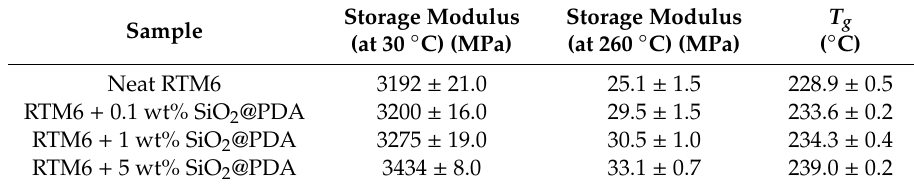
Figure 9. (a) Dynamic mechanical analysis (DMA) curves of neat epoxy and SiO 2 @PDA / RTM6 systems and ( b ) scheme of physical crosslinking of SiO 2 @PDA with epoxy chains. Table 2. Results of DMA tests for neat epoxy and SiO 2 @PDA / RTM6